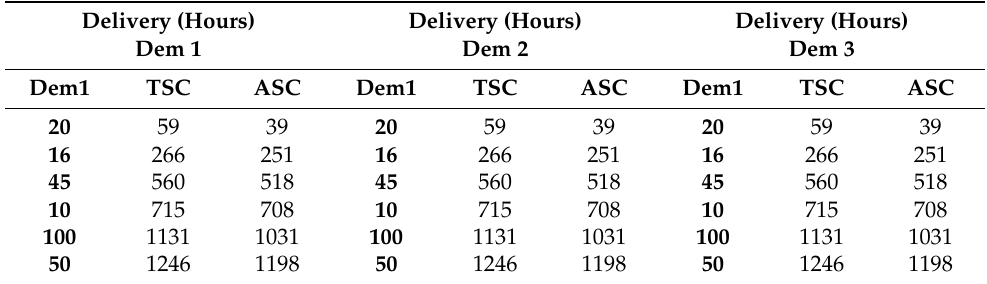
Table 7. Order completion